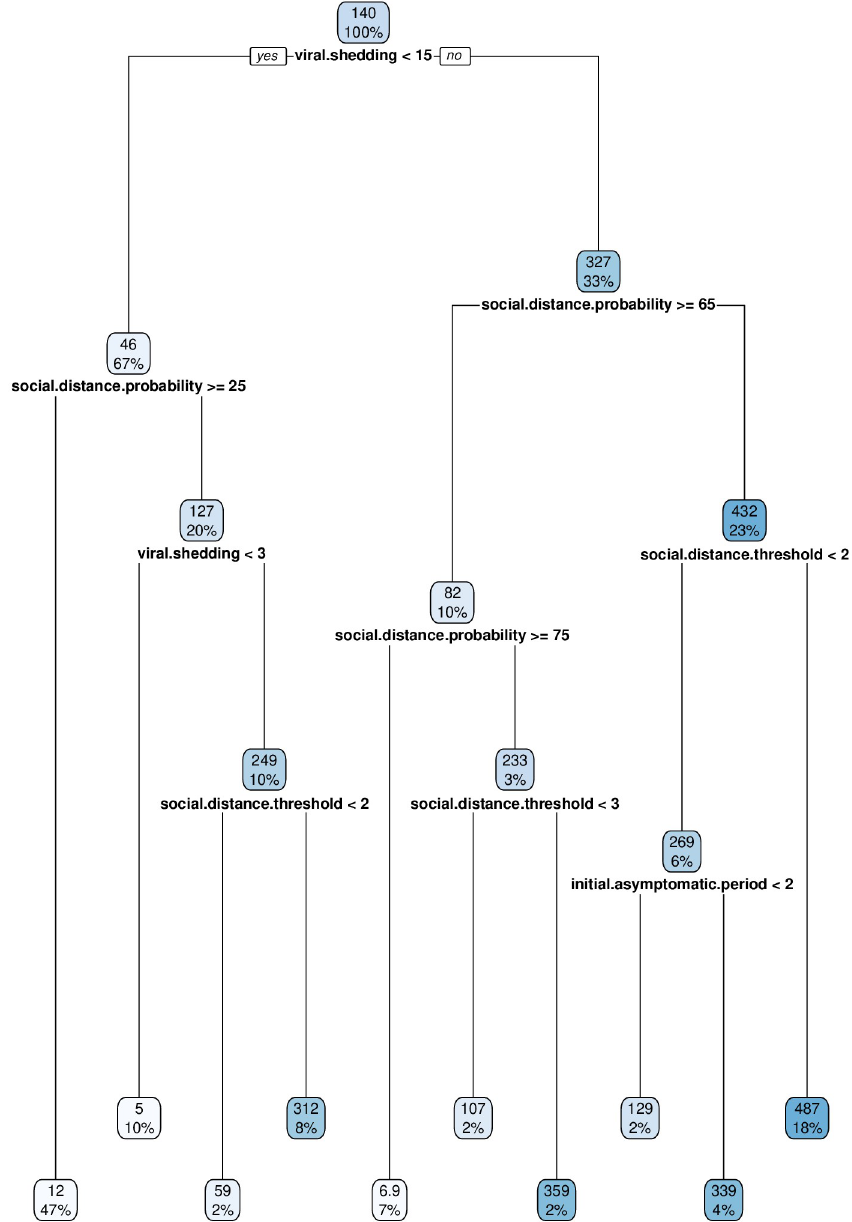
Fig 2. Regression tree for total number of infections. This tree identifies the input features with strongest influence on total number of infections. Each box contains the percentage of observations and associated mean viral load of agents. For example, in the upper-left box, 67% of the simulations had viral shedding below 15%, and for those simulations the mean number of infections was 46.